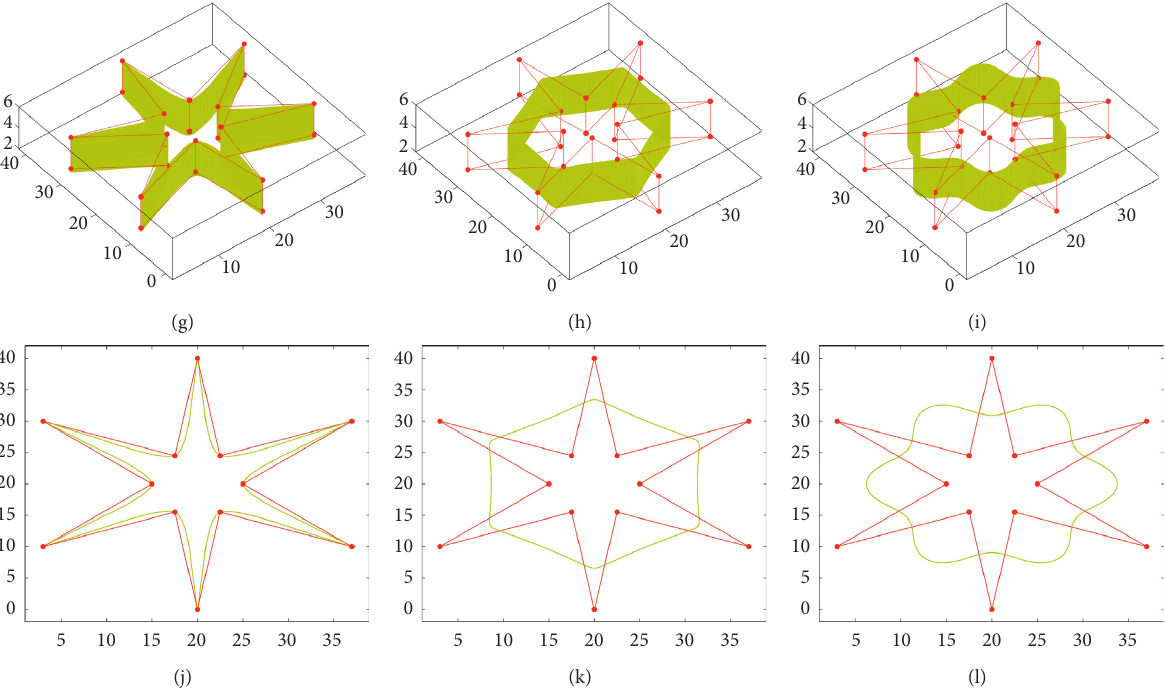
Figure 8: (a–c, g–i) The surfaces generated by the tensor product of scheme S rectangles of (a–c), respectively. (j–l) The 2-dimensional images in xy -planes of (g–i), respectively.